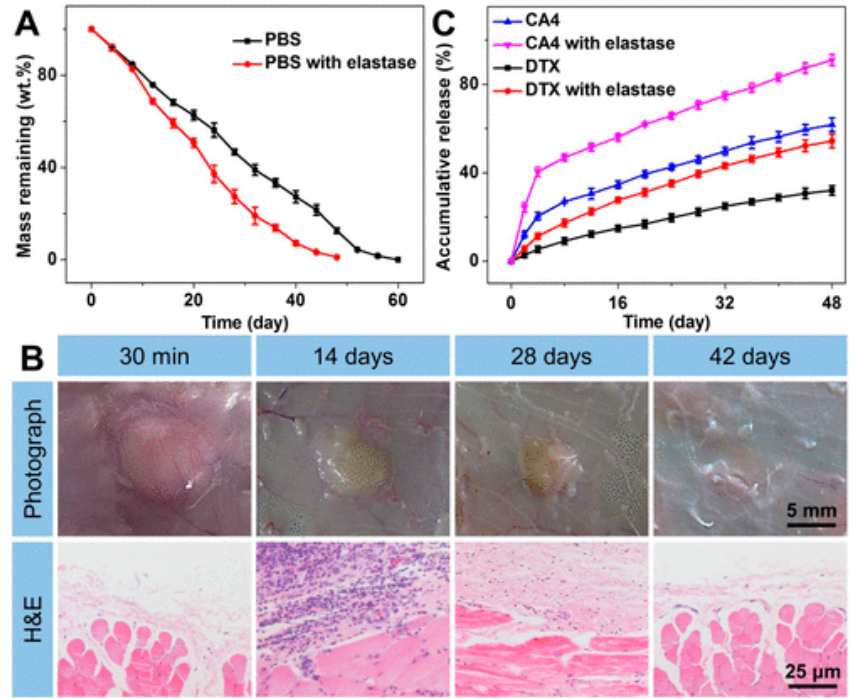
Figure 3. ( A ) Scaffold degradation over 60 days with and without elastase. ( B ) Biocompatibility was assessed through subcutaneous injection of the gel, followed by histological analysis. ( C ) Release of DTX and CA4 from the hydrogels over 48 days. Reprinted with permission from [82].